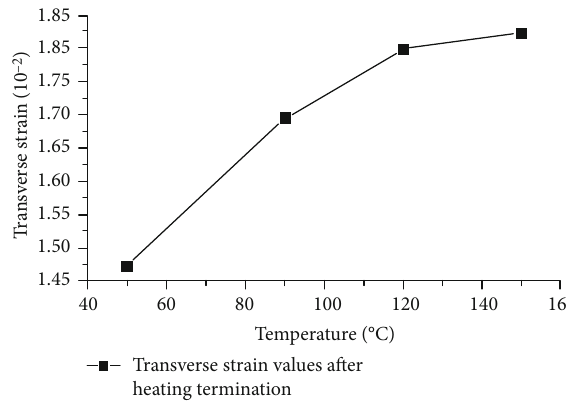
Figure 7: Transverse strain values of salt rock model after heating